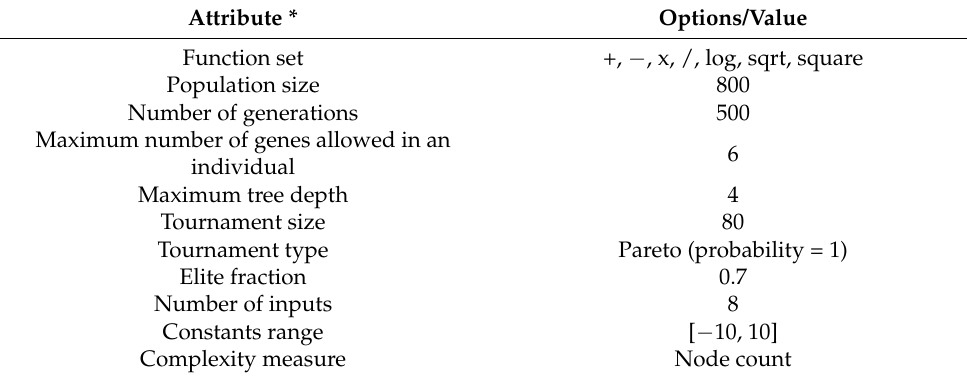
Table 3. Optimal MGGP attributes